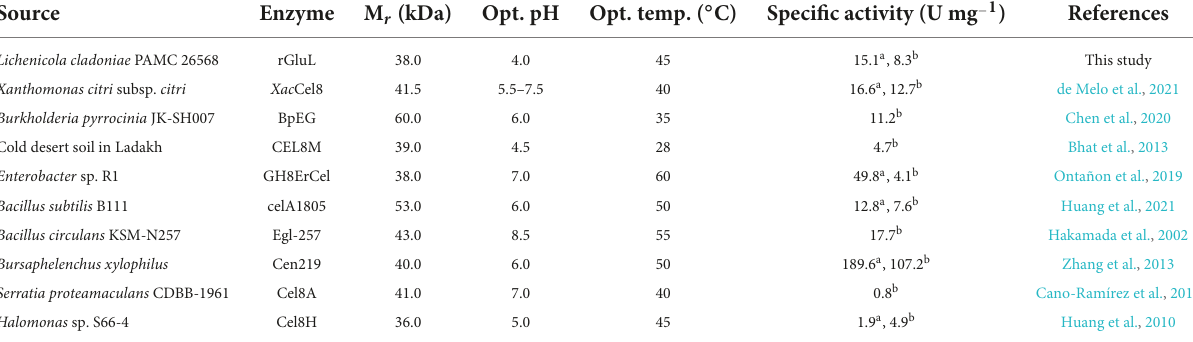
TABLE 1 Biocatalytic characteristics of microbial GH8 endo- β -1,4-glucanases. Source Enzyme M r (kDa) Opt. pH Opt. temp. ( ◦ C) Specific activity (U mg − 1 )